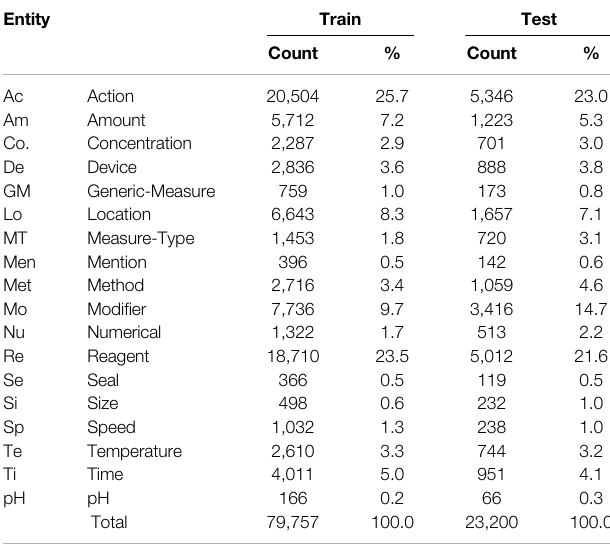
TABLE 3 | Entity distribution in the of fi cial training and test sets of the WNUT benchmark dataset.